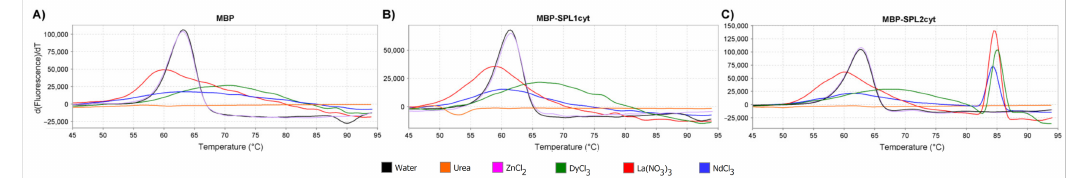
Figure 7. First derivatives of the melt curves of ( A ) MBP, ( B ) MBP-SPL1cyt, and ( C ) MBP-SPL2cyt. All proteins were assayed at 10 µ M in the presence of indicated salts (2 mM) or urea at 4 M final